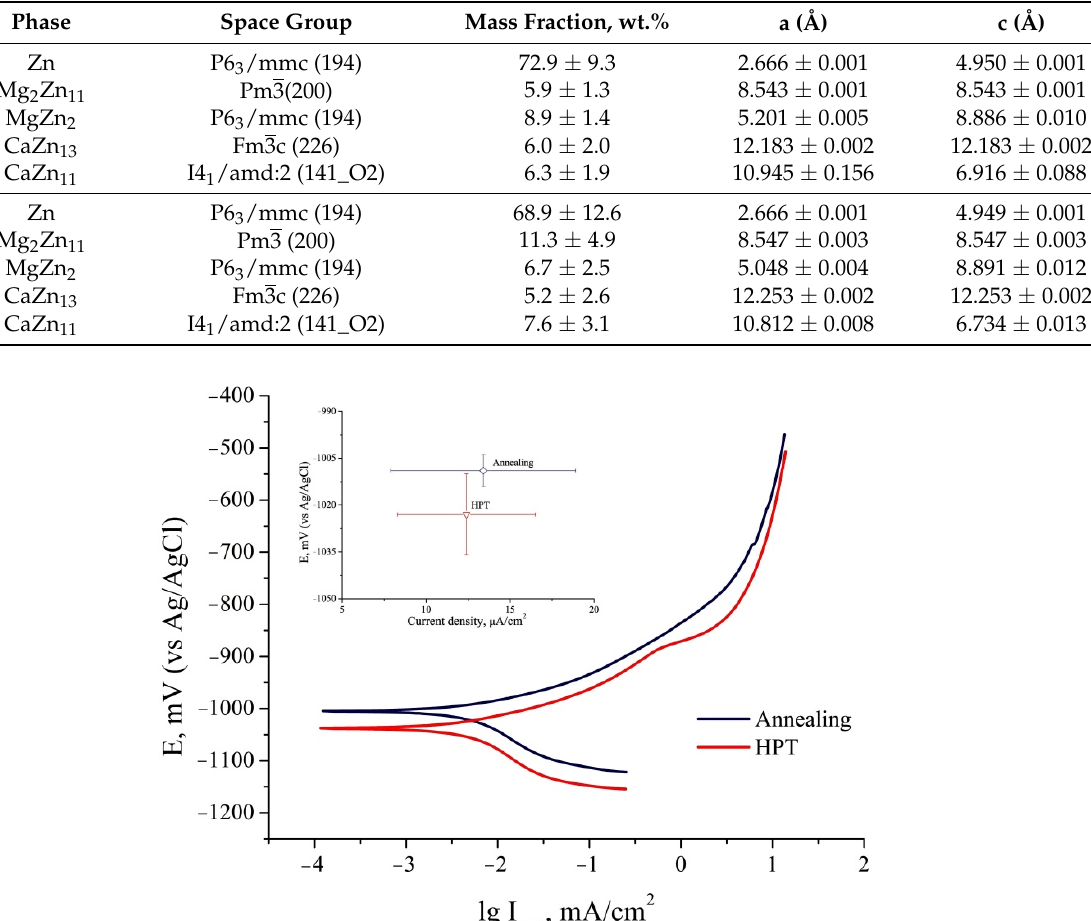
Figure 3. X-ray diffraction patterns of the Zn-1%Mg-0.1%Ca alloy after annealing ( a ) and HPT ( b ). Table 2. Results of XRD analysis (Ritveld method) of the Zn-1%Mg-0.1%Ca alloy in the initial state and after HPT processing.